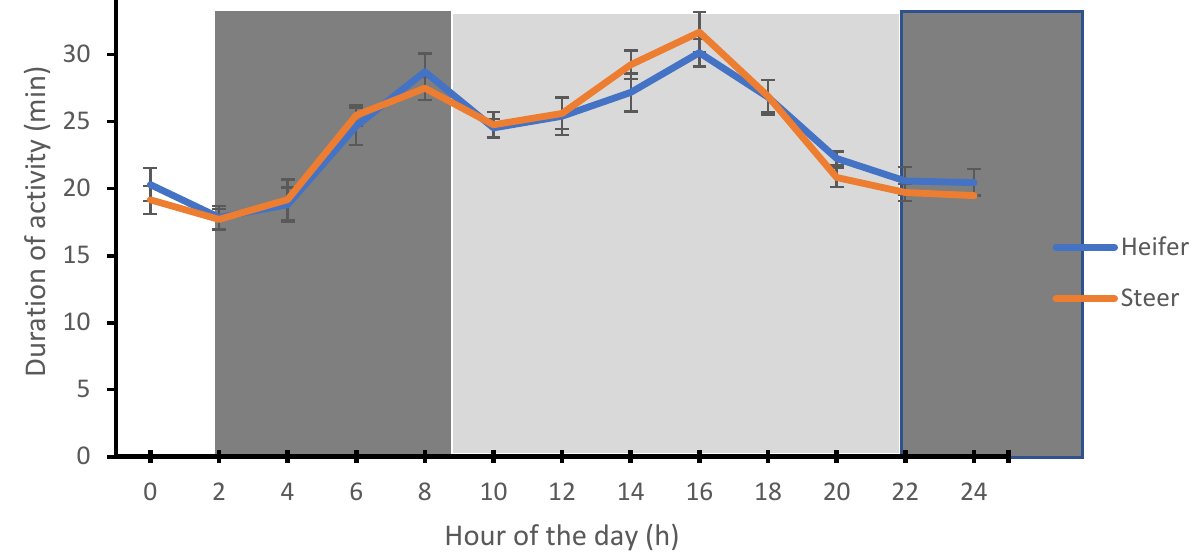
Figure 1. Circadian rhythms of rumination in heifer and steer calves. Each datum point represents the mean ± SEM of the heifer and steer at each measurement period. The light and dark shades represent the prevailing light–dark cycle.